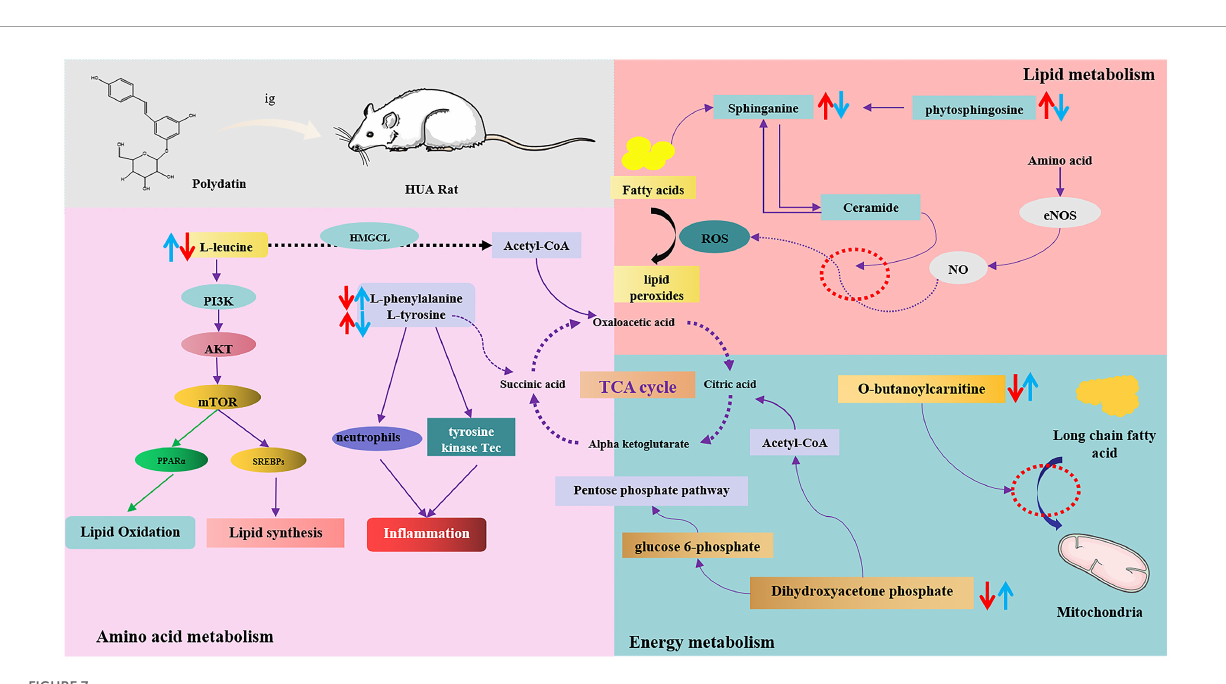
products participate in the regulation of numerous